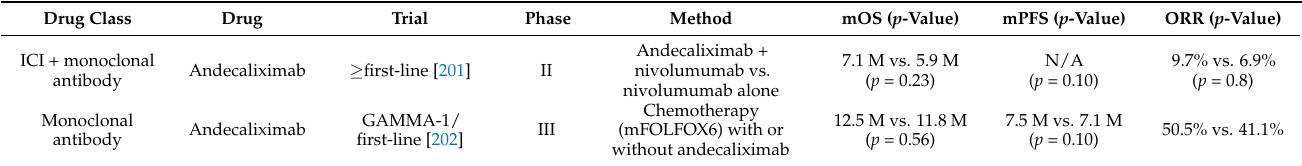
Table 9. Phase II and III trials of therapies targeting matrix metalloproteinase-9. mOS, median overall survival; mPFS, median progression-free survival; HR, hazard ratio; M, months; ORR, objective response rate.